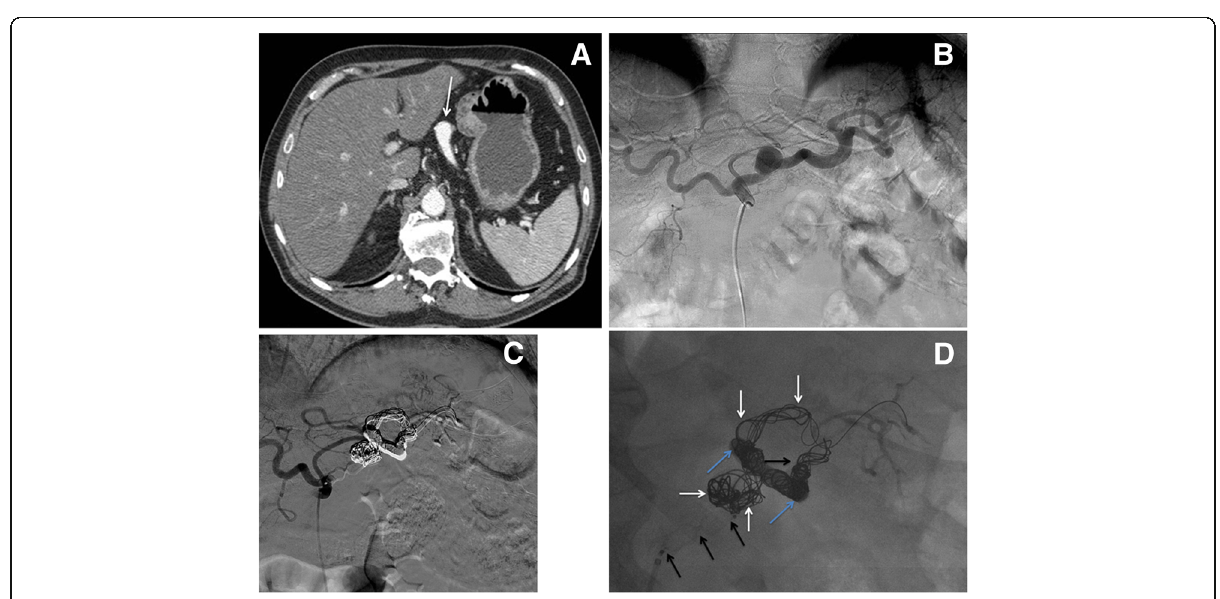
Fig. 2 Visceral artery aneurysm (VAA) embolization. a Contrast-enhanced CT in arterial phase shows a splenic artery aneurysm (white arrow). b Transfemoral diagnostic angiography of the celiac trunk confirms the presence of the splenic artery aneurysm. c After VAA embolization, DSA shows aneurysm exclusion, splenic artery occlusion with preserved patency of its distal branches through gastric collaterals. d X-rays show embolic agents used for splenic artery aneurysm embolization: Squid (light blue arrows), coils (white arrows) and Amplatzer plug (black